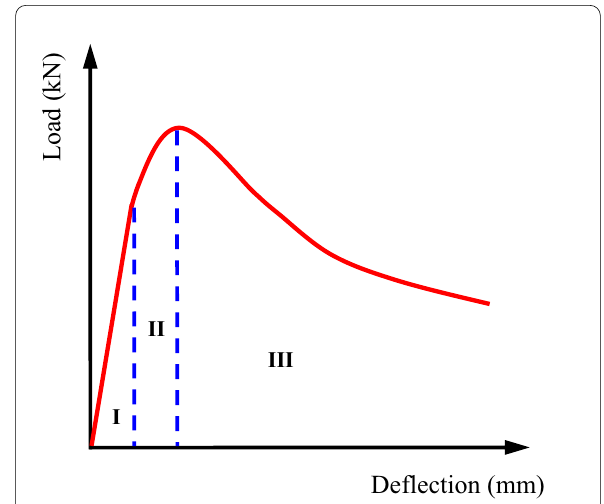
Fig. 7 Schematic pattern of load–deflection curve of BPRC.